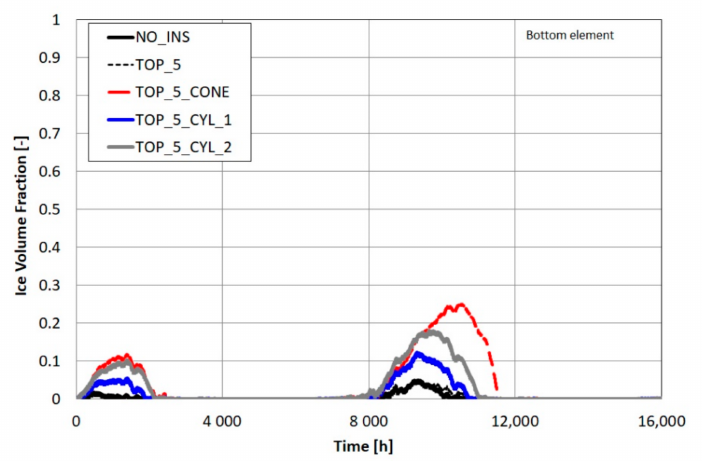
Figure 15. Ice volume fraction of the bottom element of the